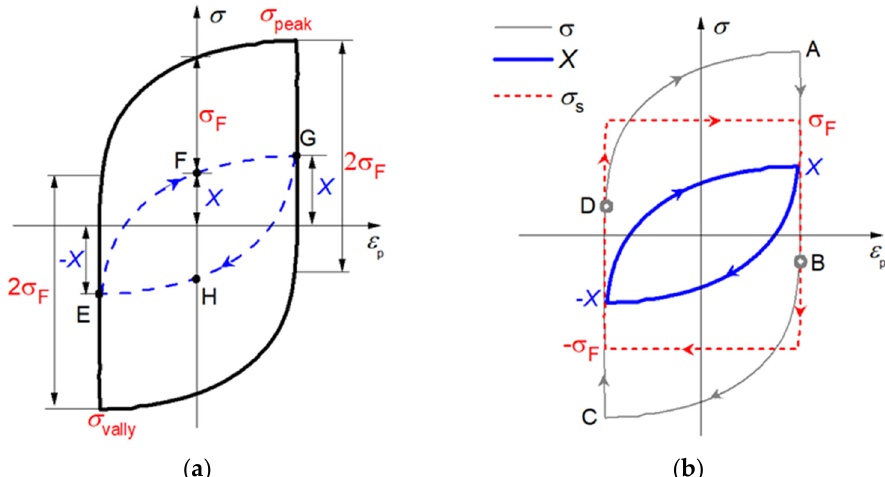
Figure 7. Internal stresses change around the loop. ( a ) back stress (blue dot lines); ( b ) friction stress (red dot